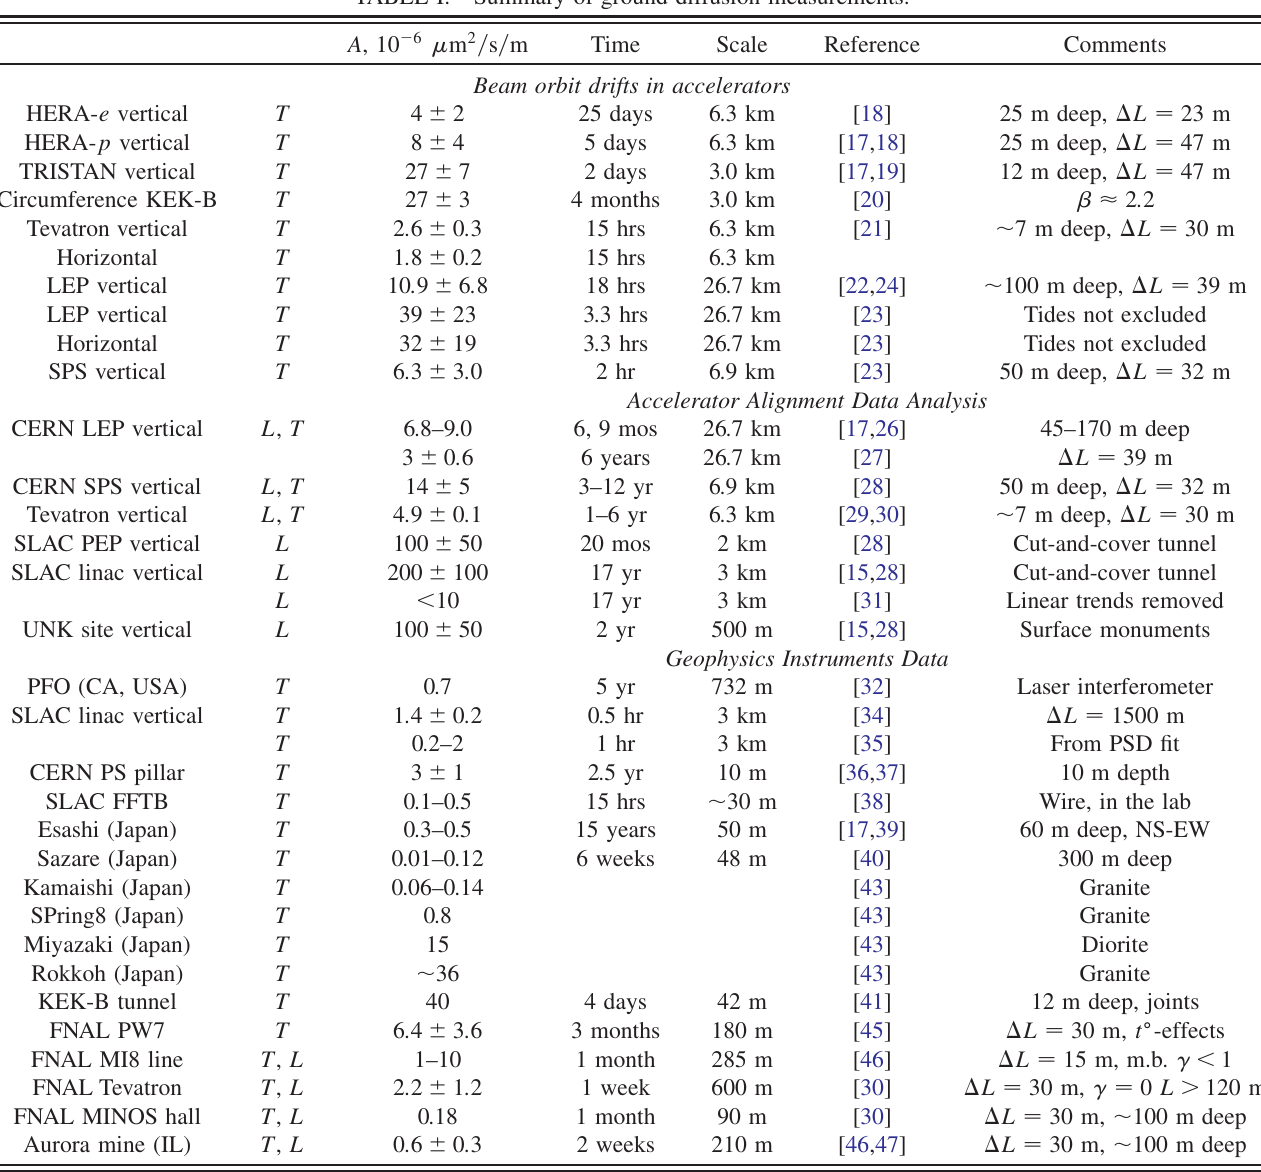
TABLE I. Summary of ground diffusion